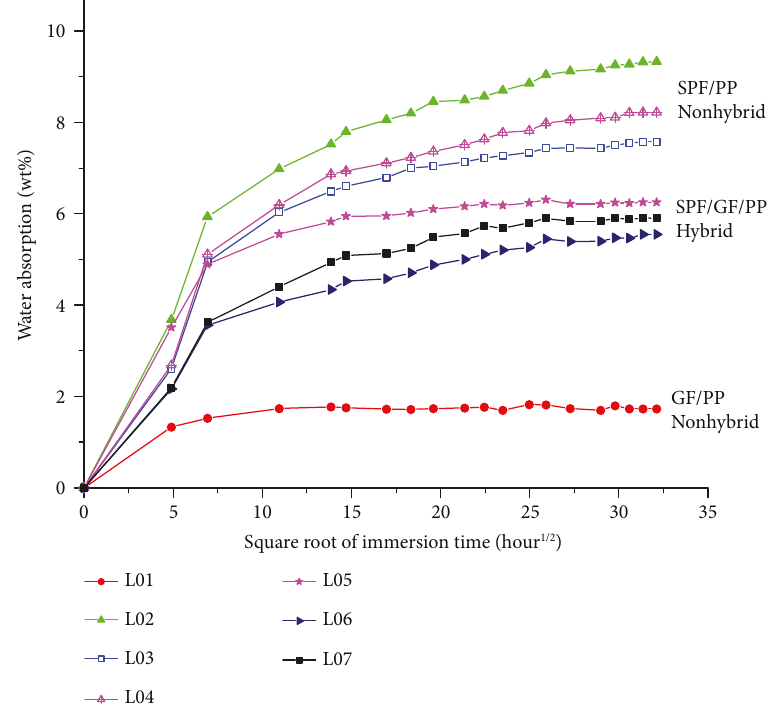
Figure 4: Water absorption of the hybrid and nonhybrid composites. Table 3: Contact angle measurement of the nonhybrid and hybrid